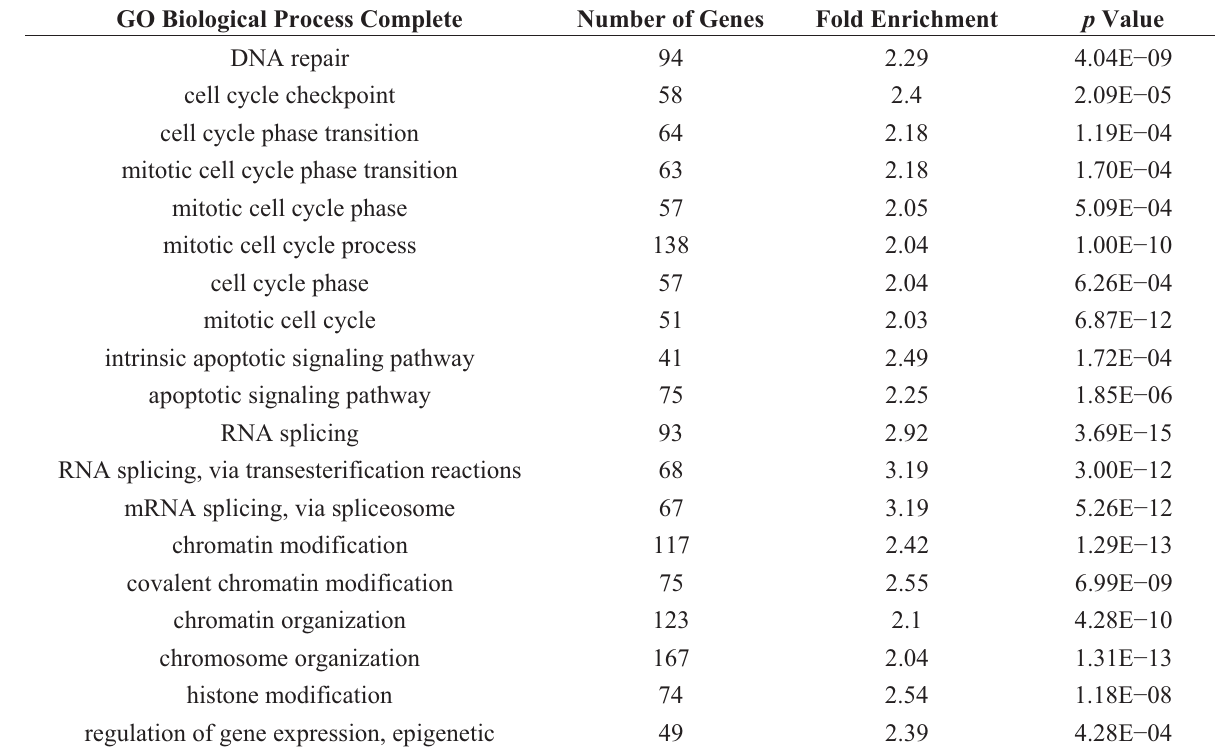
Table 3. DNA damage-induced changes in alternative splicing occur preferentially in genes implicated in DNA repair, cell-cycle control and apoptosis. We compiled alternative splicing changes occurring in 2214 genes from six studies that used camptothecin, UV and sodium arsenate (PMID number 20817775, 21163941, 20972445, 25879800, 19450518